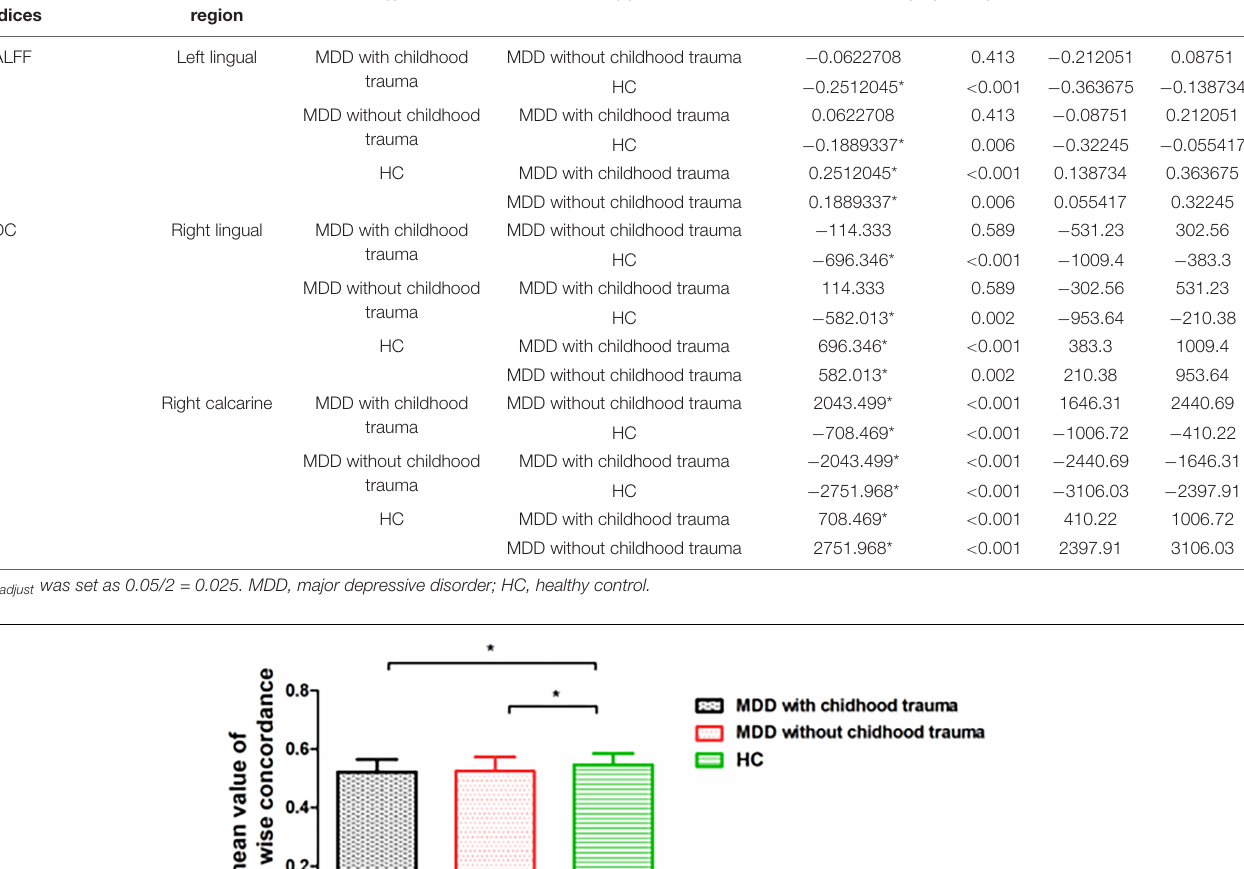
individuals with and without depression. We defined group difference (depressed or not), CTQ total score, and their interaction as independent variables; functional concordance was defined as the dependent variable; age, gender, and